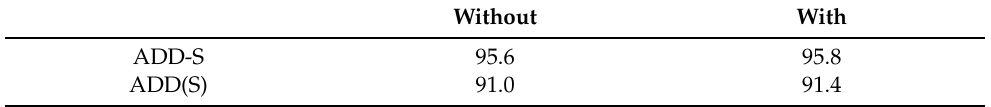
Table 4. Experiment results on YCB dataset with/withou the channel-attention. Without With ADD-S 95.6 95.8 ADD(S) 91.0